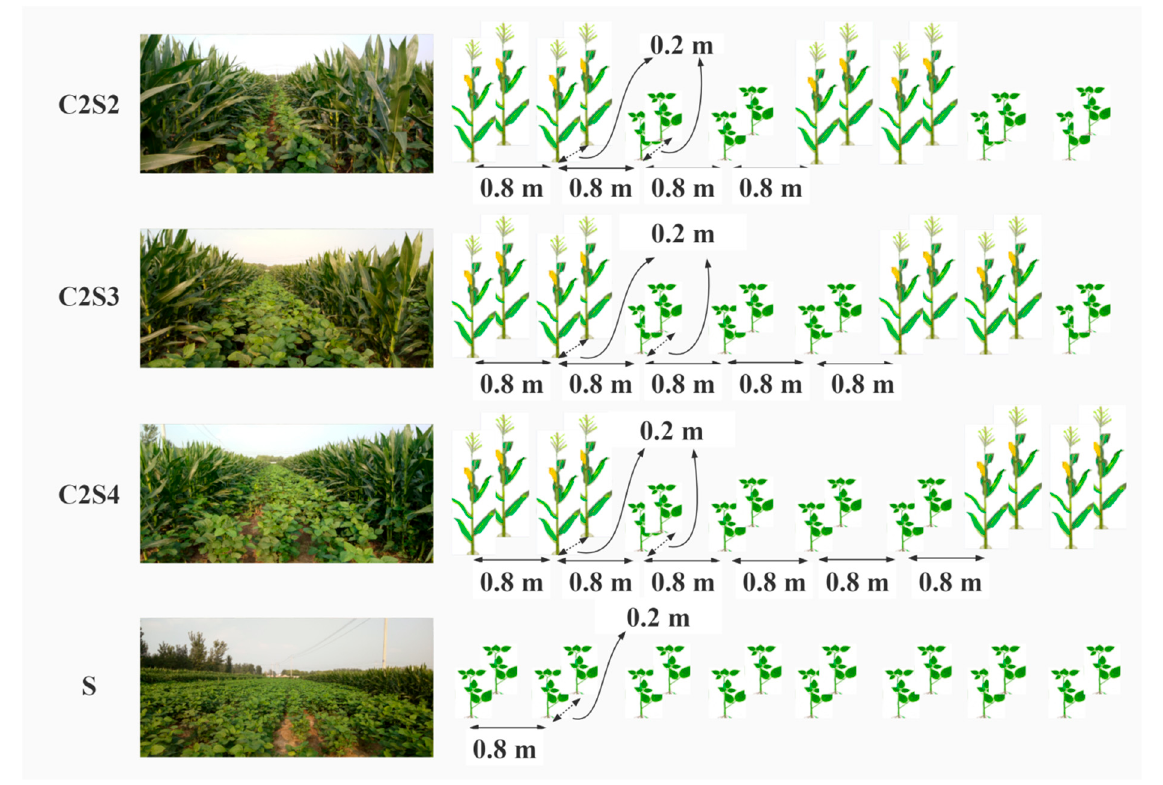
Figure 2. Diagram of different planting patterns of corn with soybean used in the present study. Note: S: sole-crop soybean; C2S2, C2S3, and C2S4: intercropping of 2 corn rows with 2, 3, and 4 rows of soybean, respectively. The row spacing and hill distance of corn and soybean were 0.8 m and 0.2 m, respectively. The spacing between corn rows and soybean rows was also 0.8 m. Two soybean plants were planted in each hill, although only one plant is shown in every soybean hill in the figure owing to the difficulty of drawing.